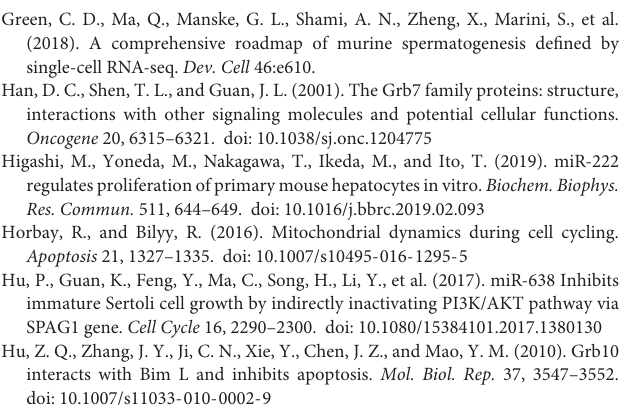
Supplementary Figure 1 | The transfection efficiency of miR-222 and GRB10. (A) The immature porcine Sertoli cells were transfected with mimic NC, miR-222 mimic, inhibitor NC, and miR-222 inhibitor ( n = 3). The relative expression of miR-222 was measured using a qRT-PCR assay. U6 was used as the internal control. (B) siRNA NC and GRB10 siRNA were, respectively, transfected in the immature porcine Sertoli cells ( n = 3). The relative mRNA expression of the GRB10 gene was detected using the qRT-PCR assay. pig-TBP was used as an internal control. Data are presented as mean ± SD. ∗ P < 0.05 and ∗∗ P < 0.01. Supplementary Table 1 | The sequences of the primers used in this